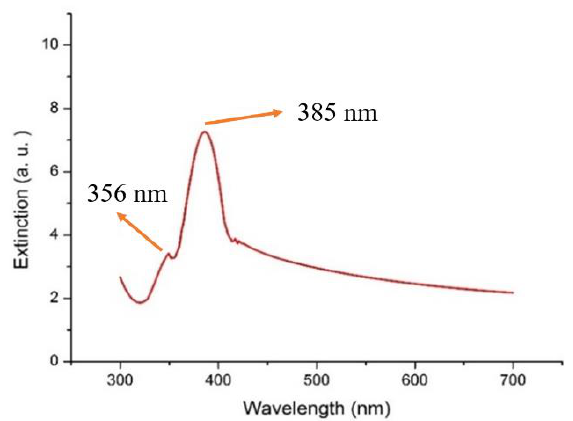
Figure 6. UV – Vis extinction spectra of the optical characteristics of the AgNW solution. Figure 6. UV–Vis extinction spectra of the optical characteristics of the AgNW